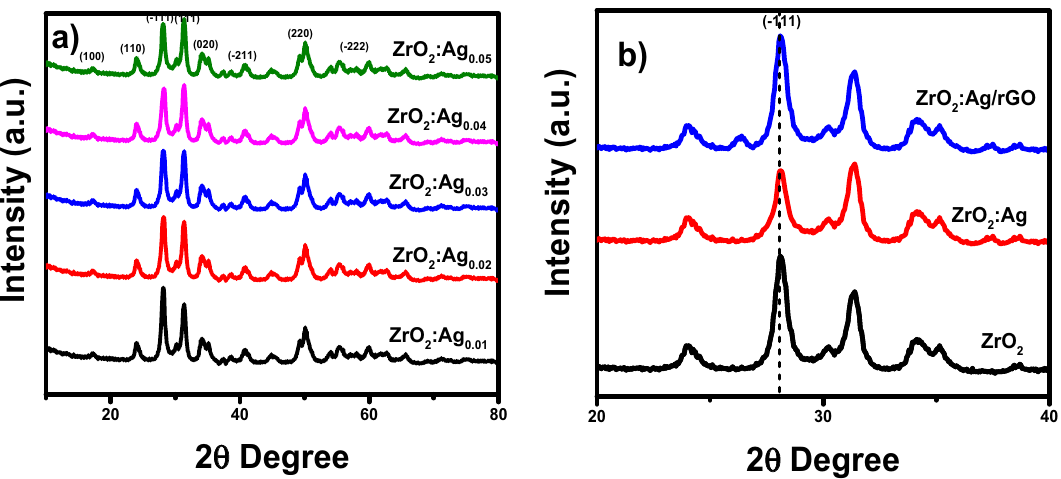
Figure 1. ( a ) XRD patterns of Ag x ZrO 2 (x = 0.01–0.05), ( b ) comparison of XRD patterns of Ag 0.04 ZrO 2 /rGO and Ag 0.04 ZrO 2 with pure ZrO 2